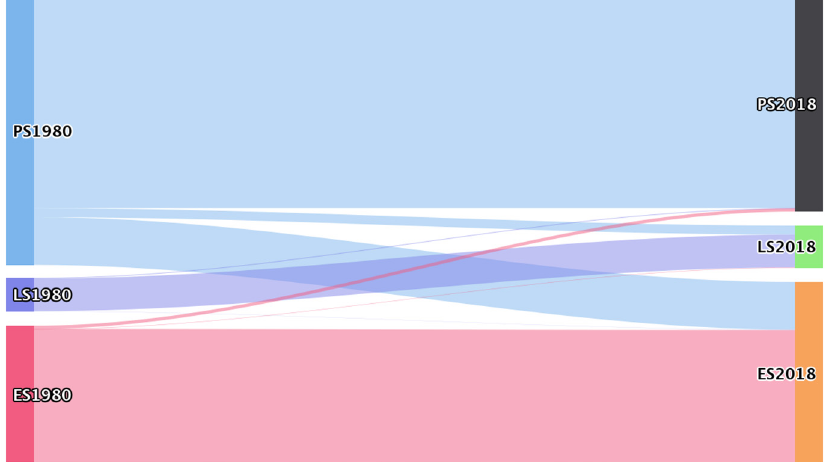
Figure 8. Sankey diagram of PLES area from 1980 to 2018.